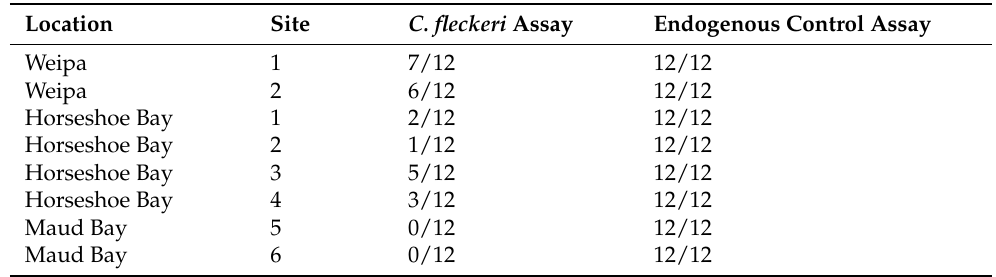
Table 3. Amplification results for in situ validation samples from Weipa, Queensland and Horseshoe and Maud Bay, Magnetic Island. Results for duplicate replicates combined.